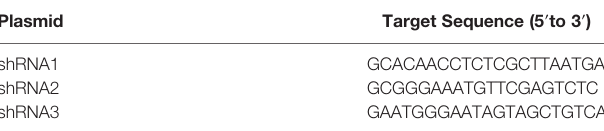
TABLE 3 | Target sequences of interfering plasmids of mouse Foxc1. Plasmid Target Sequence (5 ′ to 3 ′ )